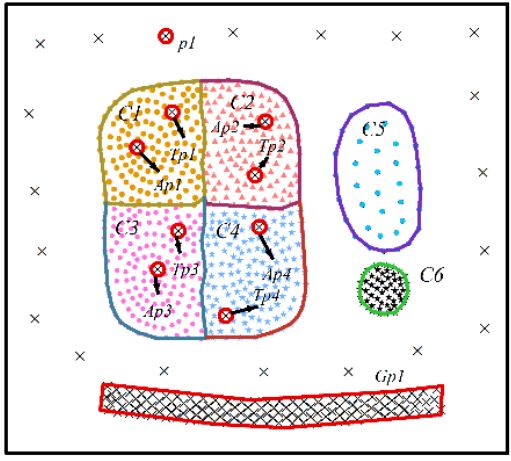
Figure 6. Spatial distribution of clusters and noises in simulated dataset S 2. ISPRS Int. J. Geo-Inf. 2016 , 5 , 205